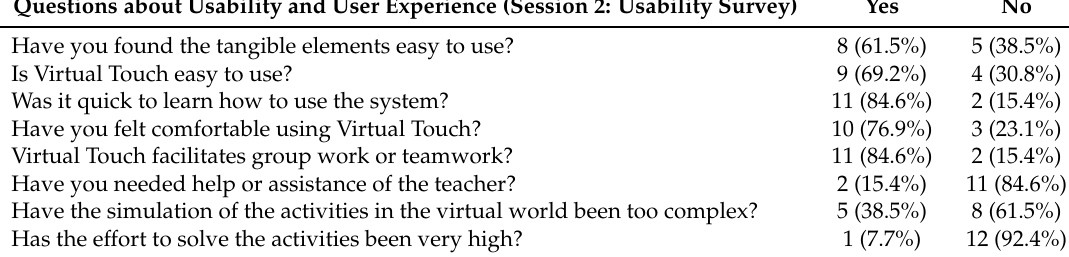
Table 3. Usability and user experience survey using Virtual Touch system (23 students).